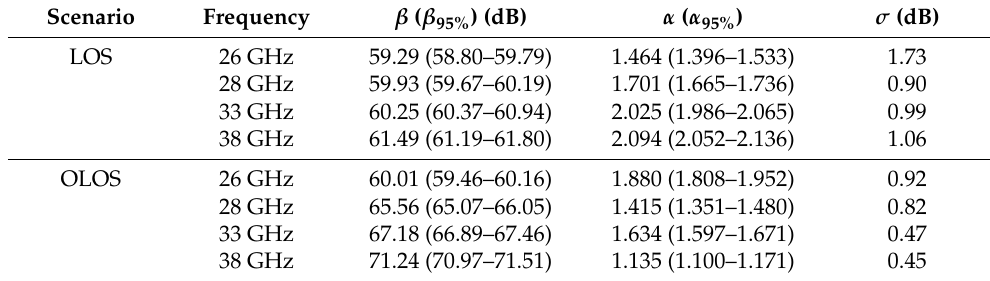
Table 4. Parameters of the FI